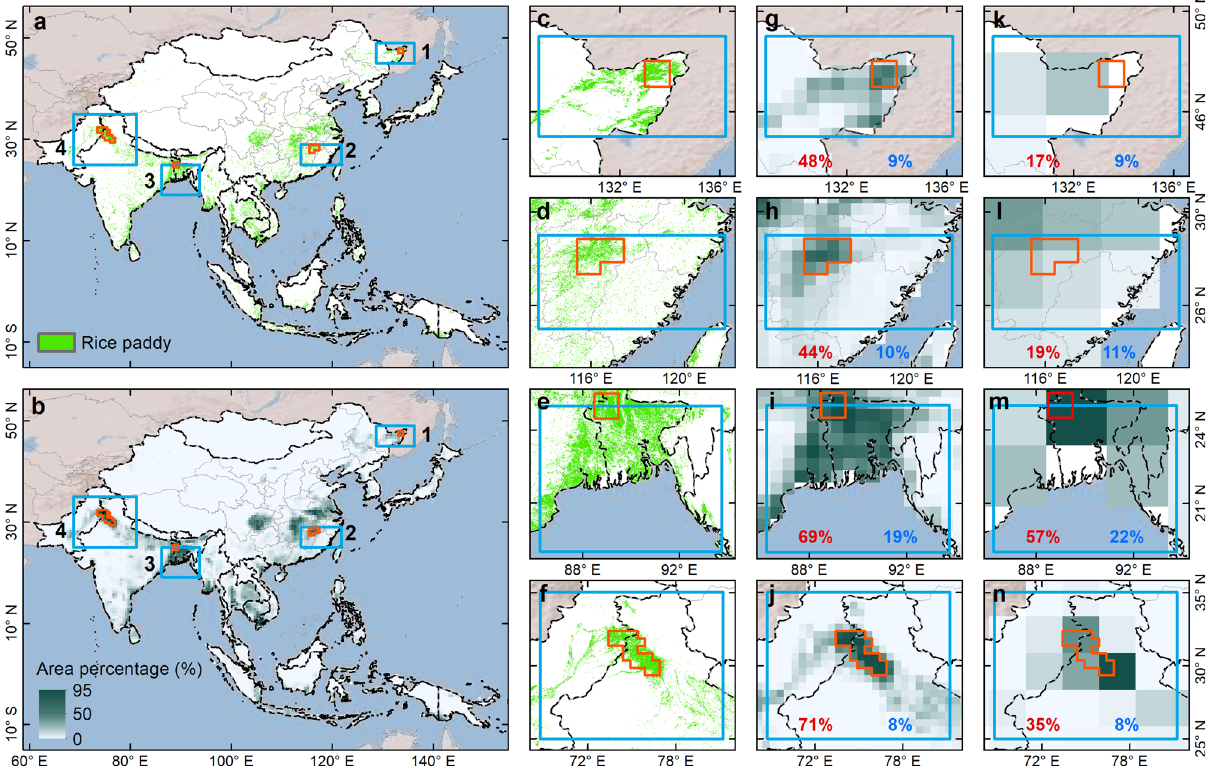
Fig. 1 Potential effects of different sizes of regions of interest (ROIs) with varied footprints of rice paddies. The red and blue ROIs are from our study 1 and Zeng et al. 2 , respectively. The paddy rice maps were retrieved from MODIS data with the 500-m spatial resolution ( a ) and 0.5° spatial resolution ( b ) in monsoon Asia in 2010, respectively. Detailed spatial distributions of rice paddies in local regions labeled with blue rectangles and spatial resolutions of 500 m ( c – f ), 0.5° ( g – j ), and 2° × 2.5° ( k – n ). The red and blue numbers show the mean of rice paddy area proportion in ROIs with red and blue color,